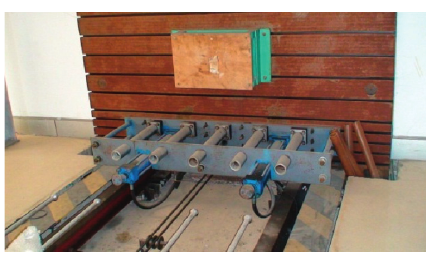
Figure 4: Collision